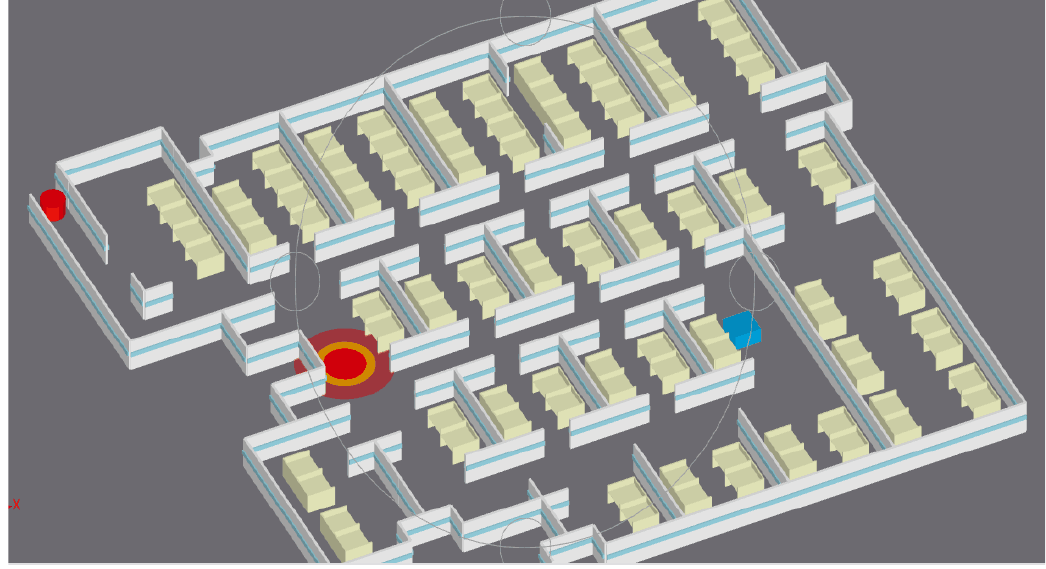
Figure 8. 3D virtual scene map of an office building fire.